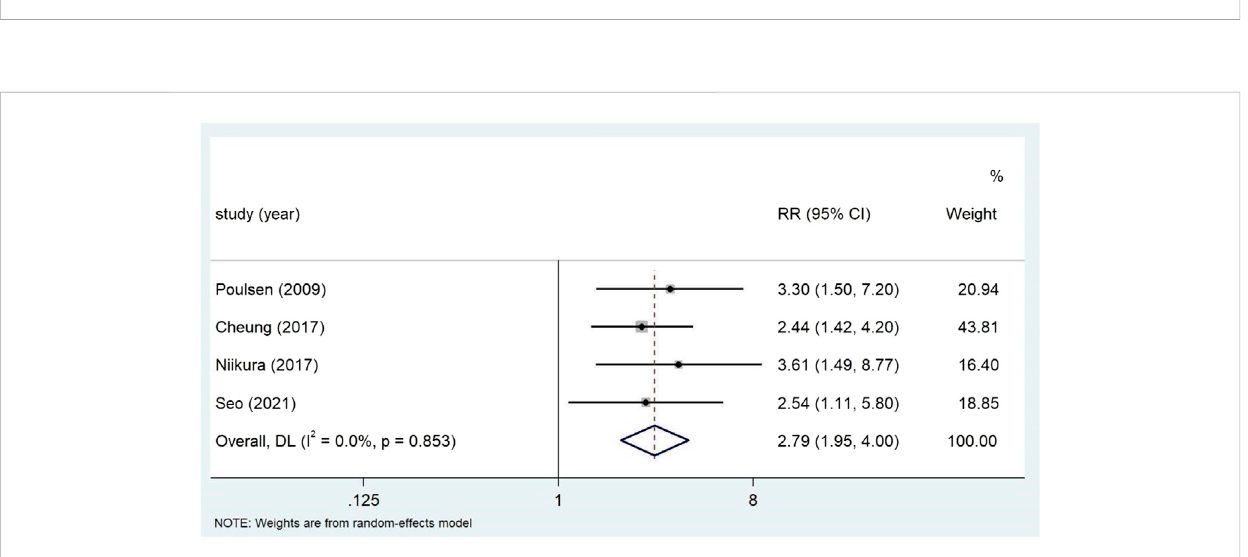
FIGURE 5 PPI users after Helicobacter pylori